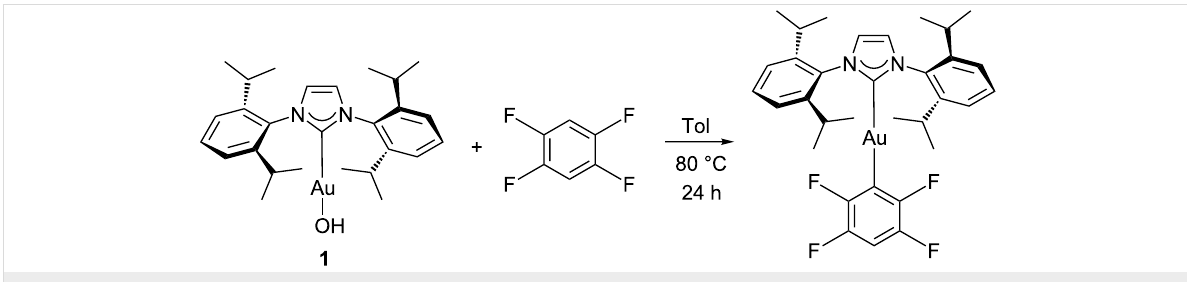
zene ( 2 , p K a DMSO 31.5 [15]) using a mixture of reagents